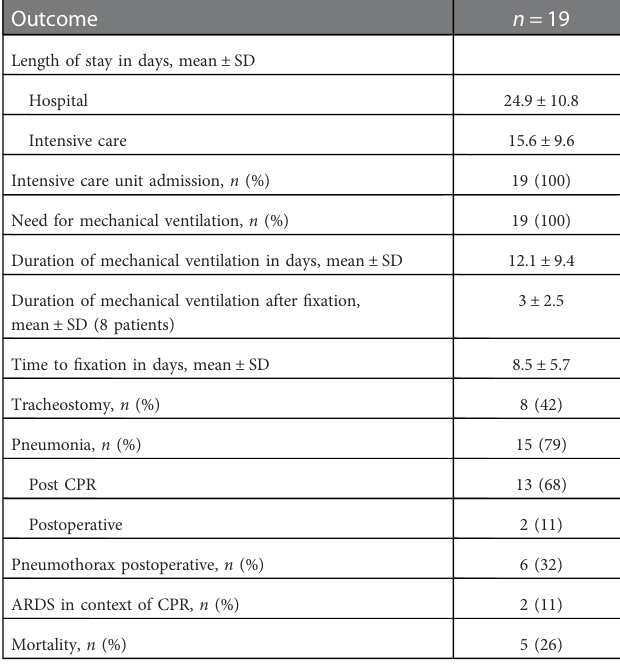
TABLE 3 In-hospital outcomes.